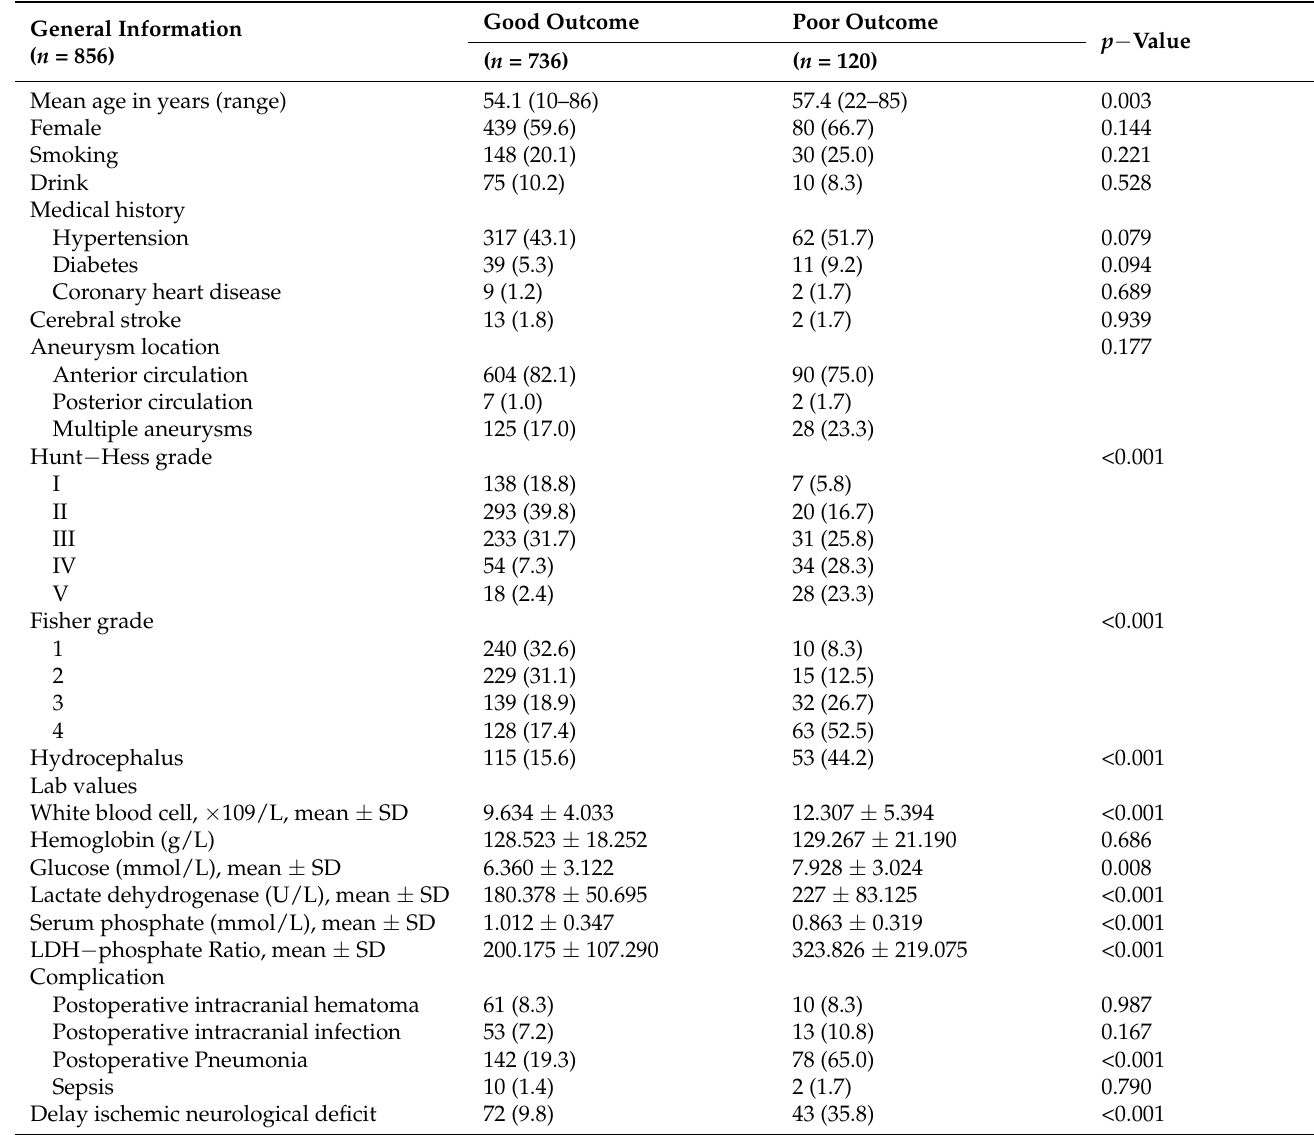
Table 2. Univariate analysis of the risk factor of ruptured intracranial aneurysm for poor outcomes at 3